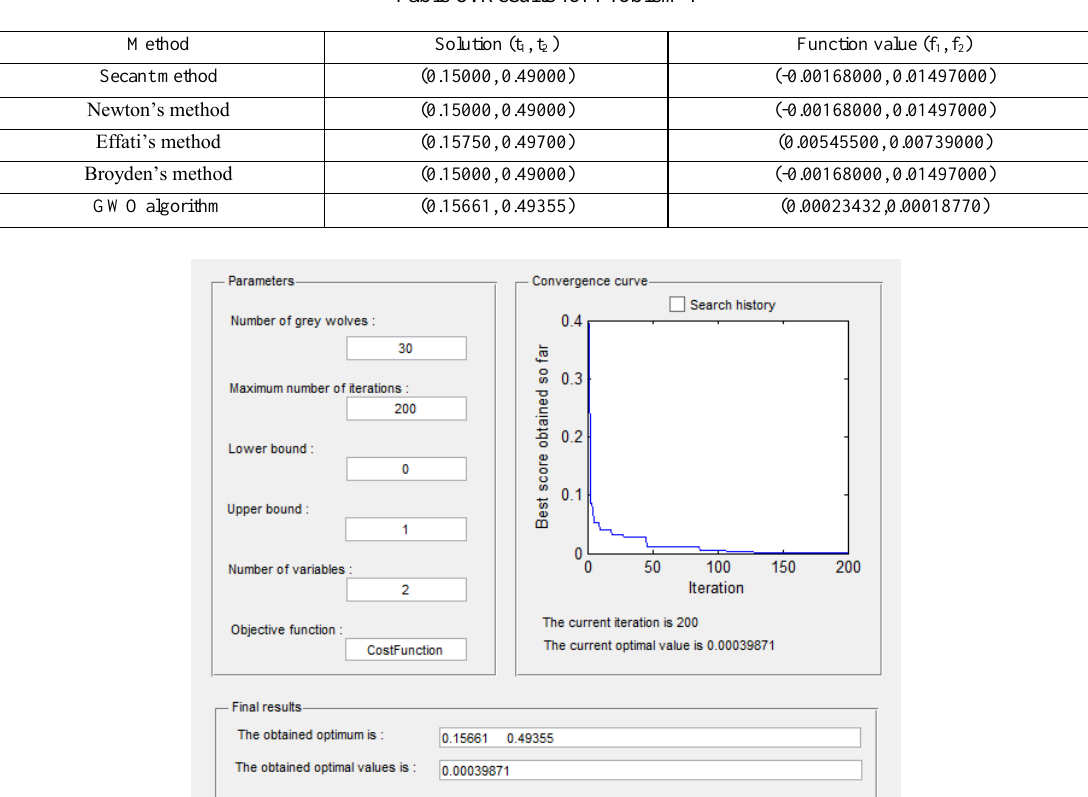
Figure 3. GWO Search history for Problem